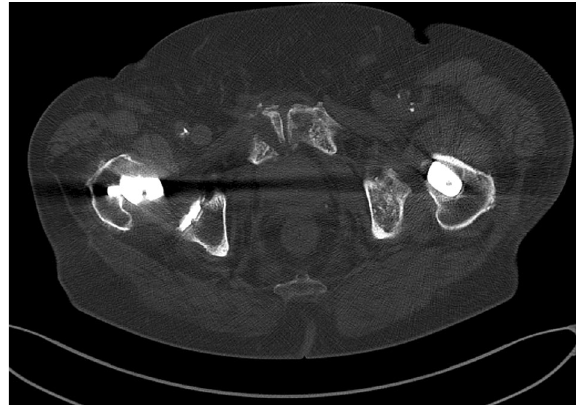
Figure 2. Fracture of the anterior ring showing a right-sided pubic bone fracture.